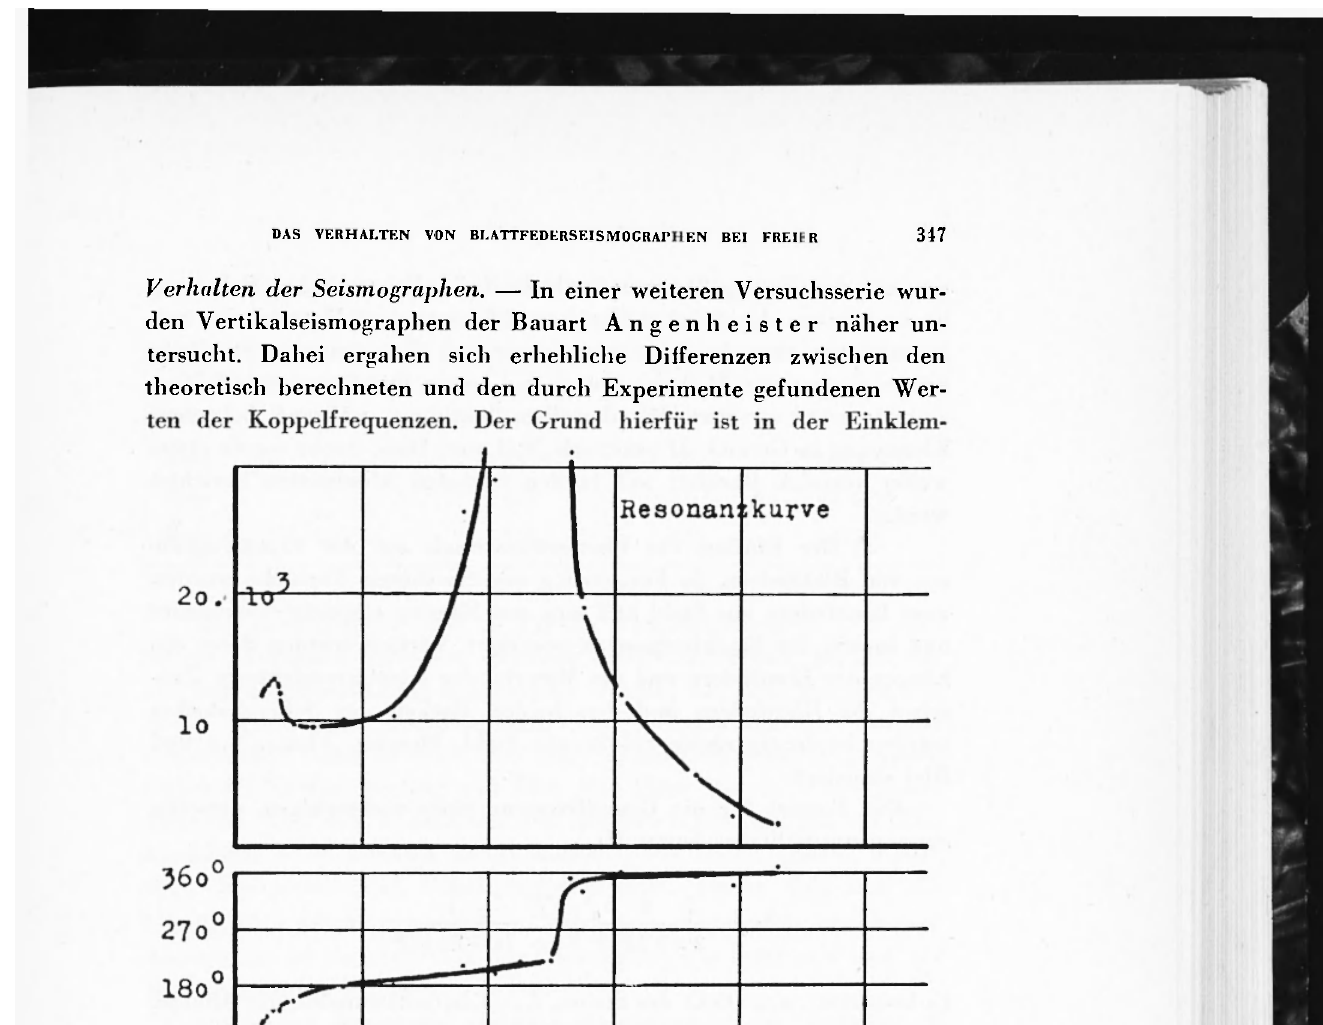
Fig. 6 - Resonanz- und Phasenkurve des Vertikalseismographen Z12. Die Blattfe- dern waren zwiscben ausgegliihte Messingbacken geklemmt. Die freie Liinge der Blattfedern betrug 0,02